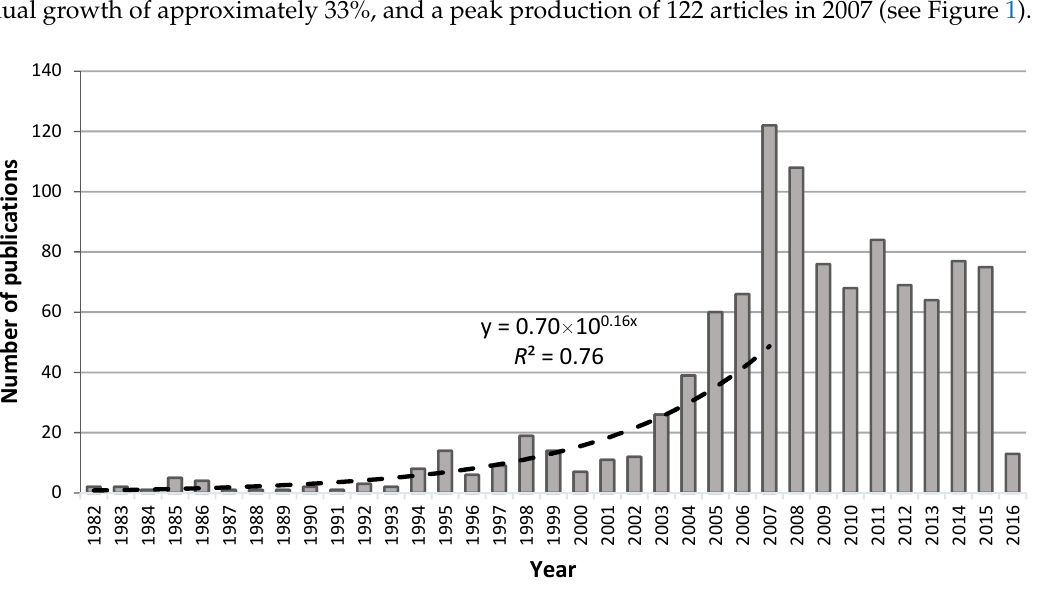
Figure 1. Evolution of published traditional Chinese medicine (TCM) research in the period 1982–2016 (dashed line represents the exponential tendency between 1982 (x = 1) and 2007 (x = 26)). R 2 is the coefficient of determination, which gives the percentage variation in “ y ” explained by the variable “ x ”.